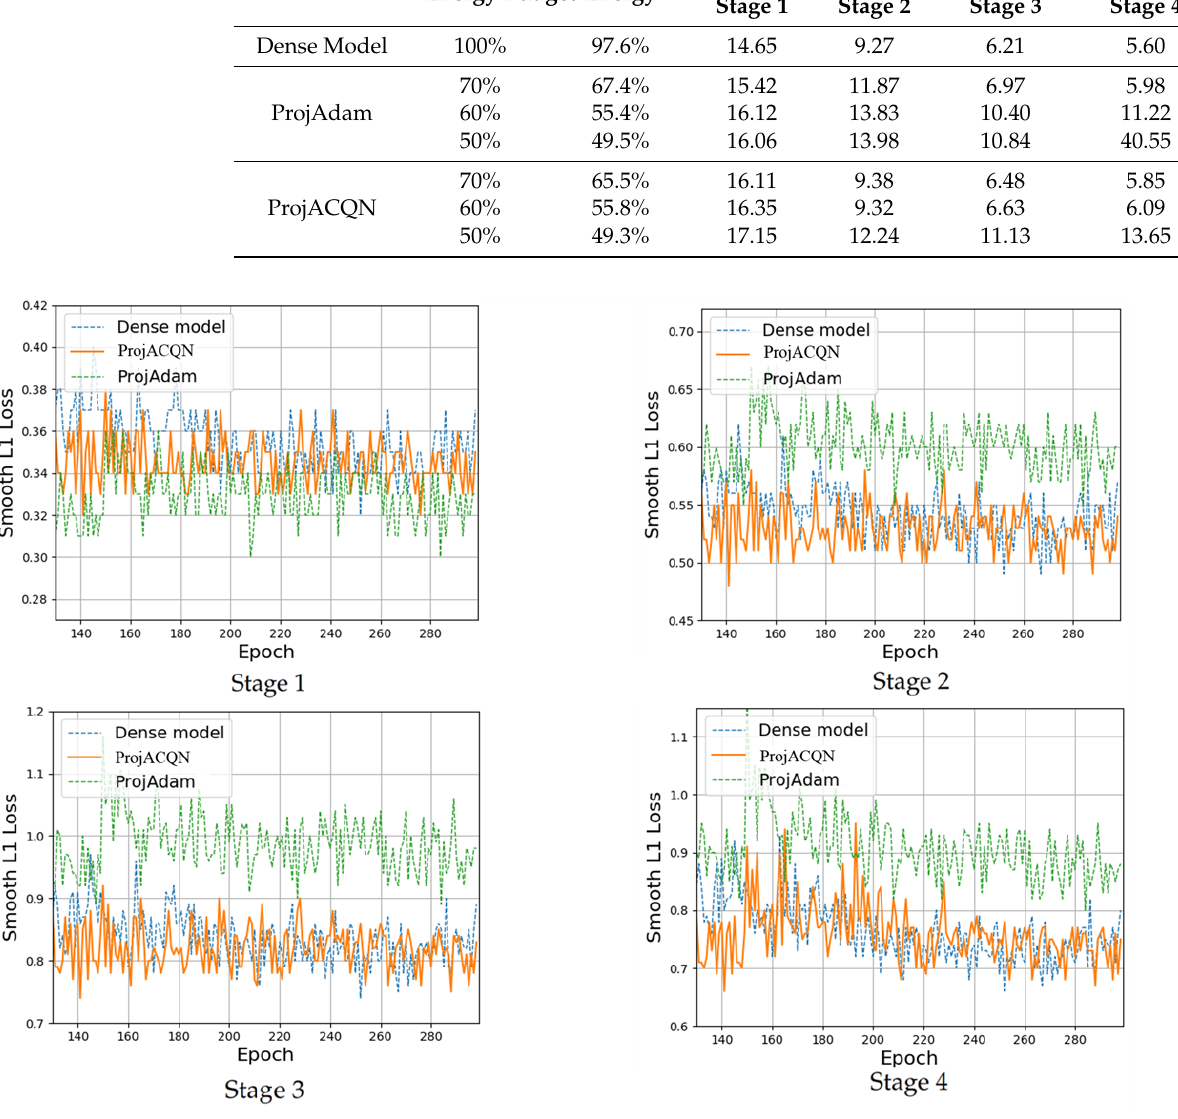
Figure 2. The training loss curves of four stages on KITTI-2015 under 70% energy cost. Table 2. Three-pixel error (%) and resulting energy consumption of AnyNet with 50%, 60% and 70% energy budget on KITTI-2015 datases. A lower three-pixel error is